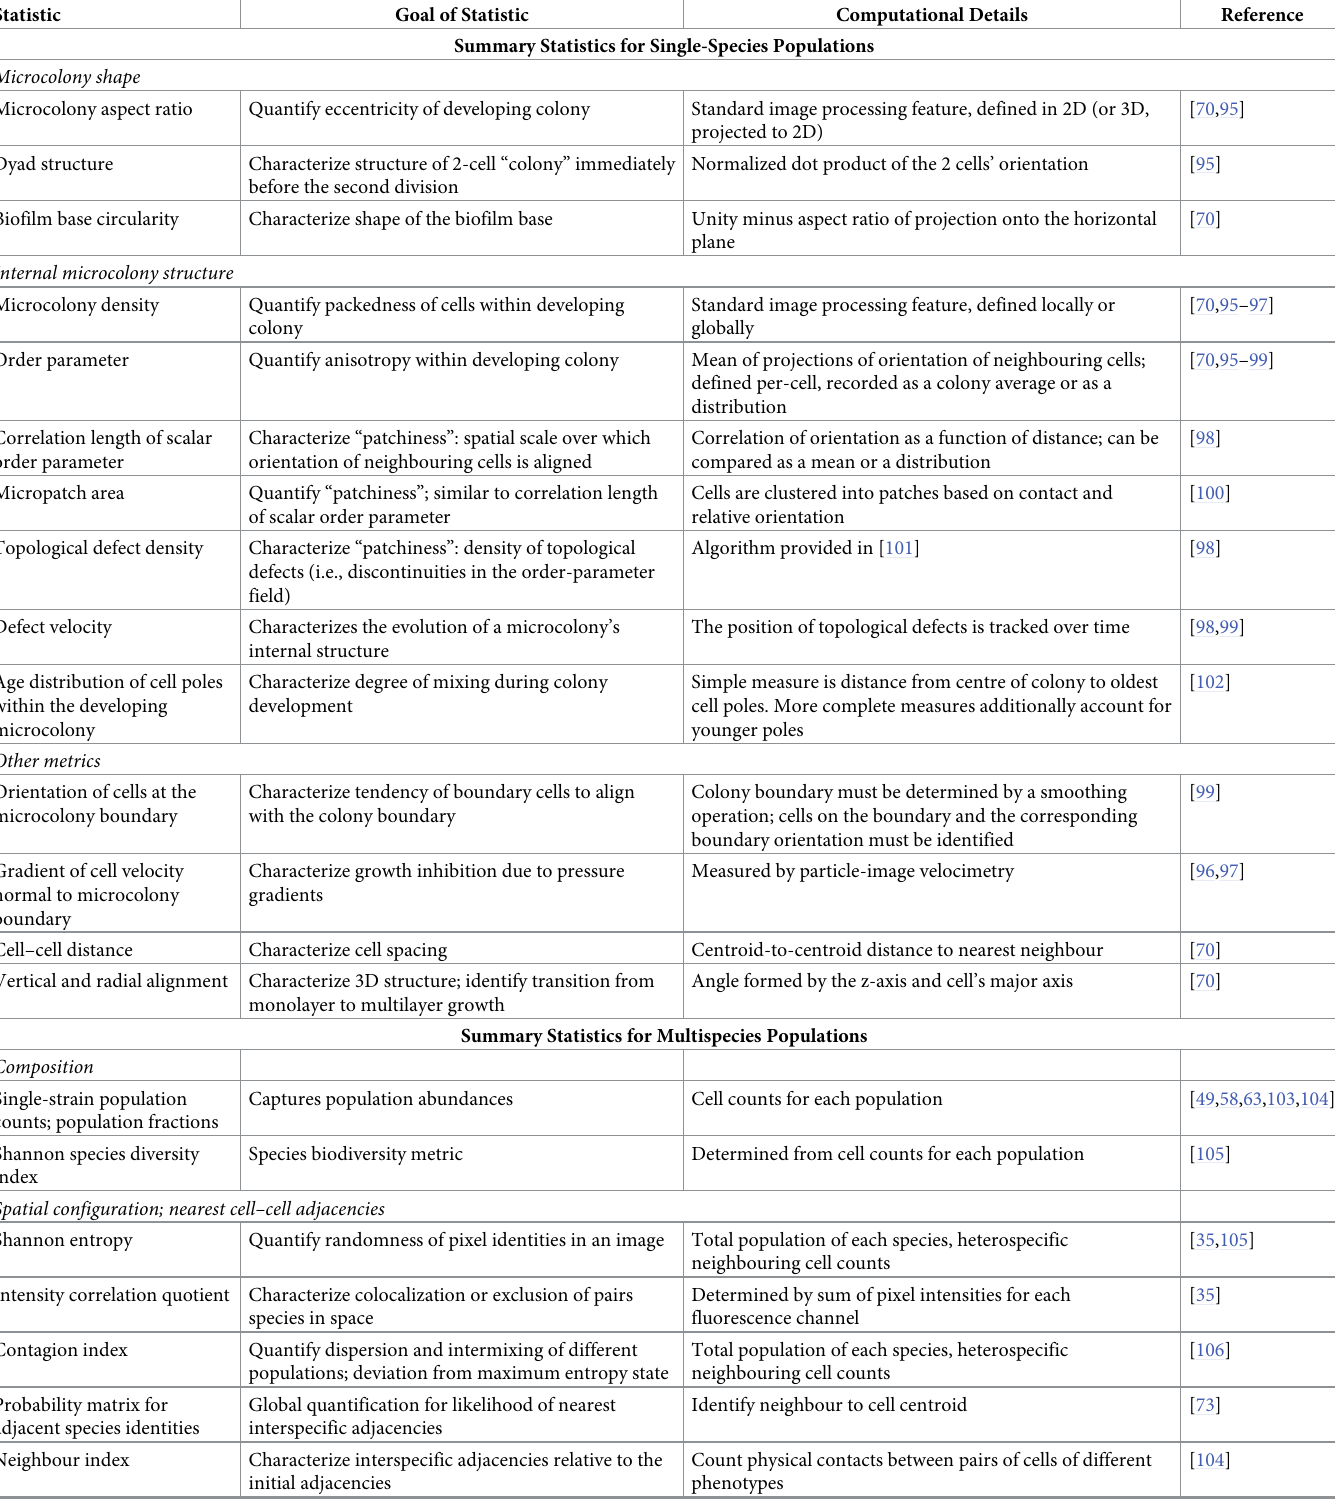
Table 1. Summary statistics for quantifying features in microbial